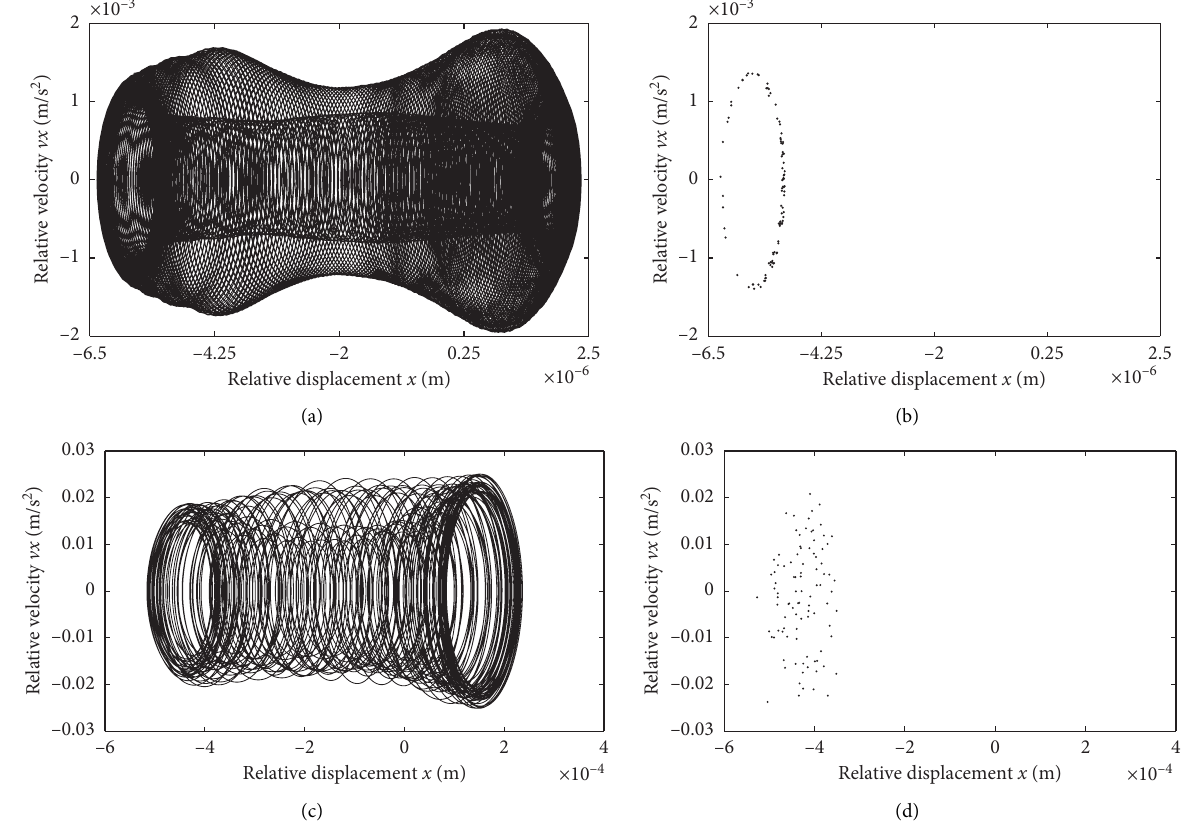
Figure 24: Phase trajectories and Poincare maps of X -direction clearances with different clearance values at clearance A. (a) Phase trace diagram at clearance A when the clearance value is 0.01mm. (b) Poincare map at clearance A when the clearance value is 0.01mm. (c) Phase trace diagram at clearance A when the clearance value is 0.8mm. (d) Poincare map at clearance A when the clearance value is